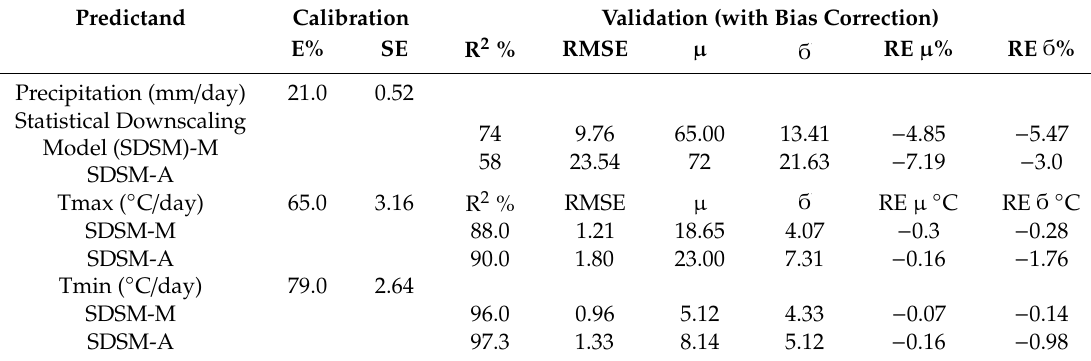
Table 2. Statistical comparison of downscaled and observed mean monthly precipitation, maximum and minimum temperatures, during calibration and validation after bias correction. Predictand Calibration Validation (with Bias Correction) E% SE R 2 %